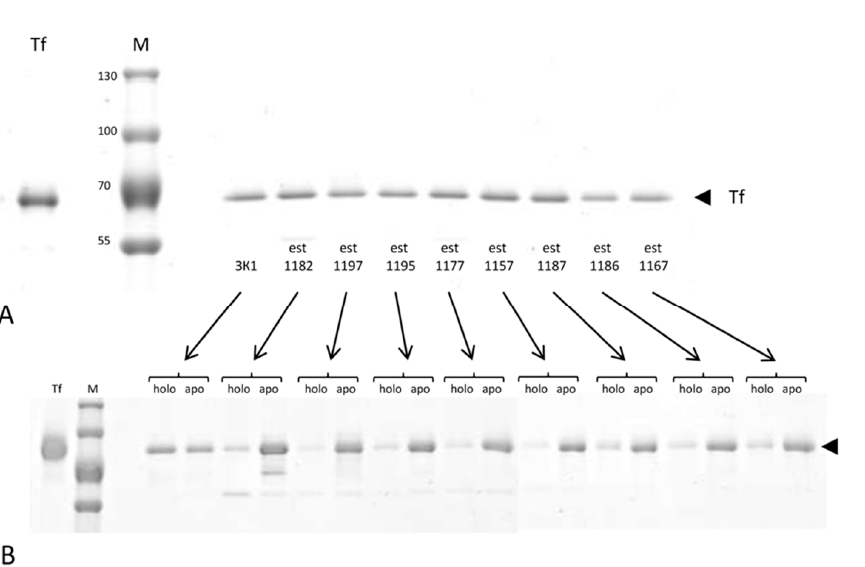
Table 6. The serum ratio of holo-transferrin to apo-transferrin in the study group and the control group, as determined by immunoaffinity chromatography.